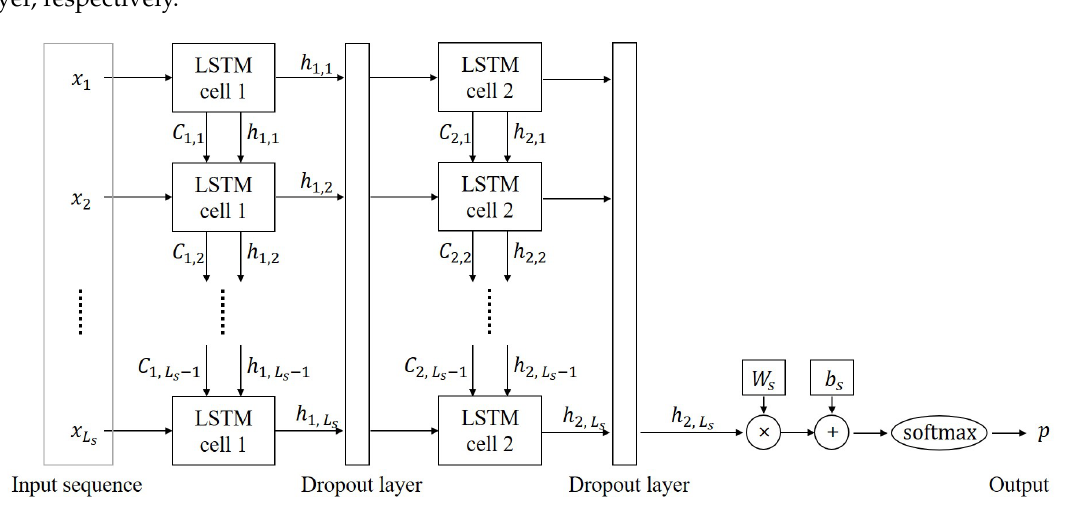
Figure 3. Structure of the multi-layer LSTM